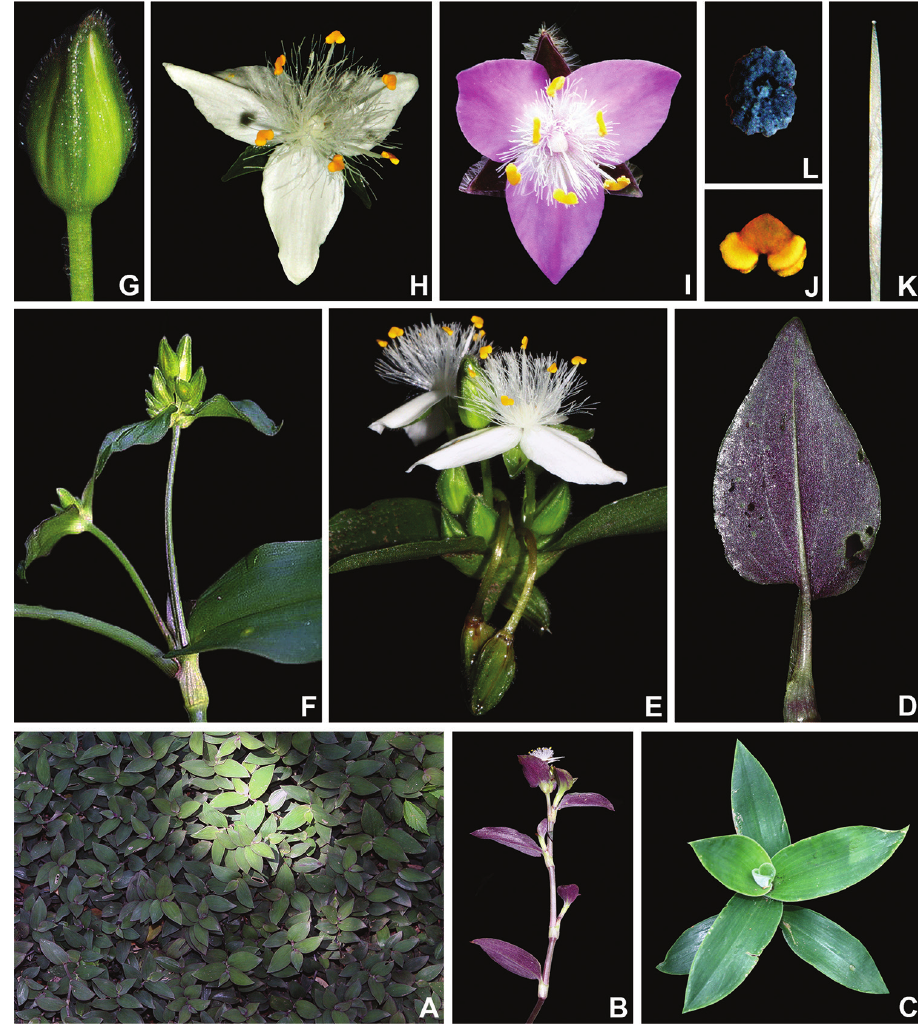
Figure 9. Tradescantia subg. Austrotradescantia (D.R.Hunt) M.Pell. A–C habit: A prostrate, mat-form- ing habit of T. cymbispatha C.B.Clarke B detail of a branch of T. cymbispatha , showing the distichously-al- ternate leaves C young specimen of T. cerinthoides Kunth, showing the rosette habit and spirally-alternate leaves D subpetiolate leaf of T. tenella Kunth E–F inflorescence: E inflorescence of T. fluminensis Vell., showing the leaf-like, saccate cincinni bracts, and deflexed pedicels at post-anthesis F synflorescence of T. umbraculifera Hand.-Mazz., showing two inflorescence per leaf axil, and spathaceous, saccate cincinni bracts G floral bud of T. fluminensis , showing three keeled sepals H–I flowers: H flower of T. fluminensis , showing the white, plicate petals I flower of T. cerinthoides , showing the pink, flat petals J anther of T. fluminensis , showing the rhomboid connective and elliptic anther sacs K style of T. fluminensis , showing the punctate stigma L seed of T. cerinthoides , showing the costate testa cleft towards the embryotega, and the inconspicuous embryotega. All photos by M.O.O.